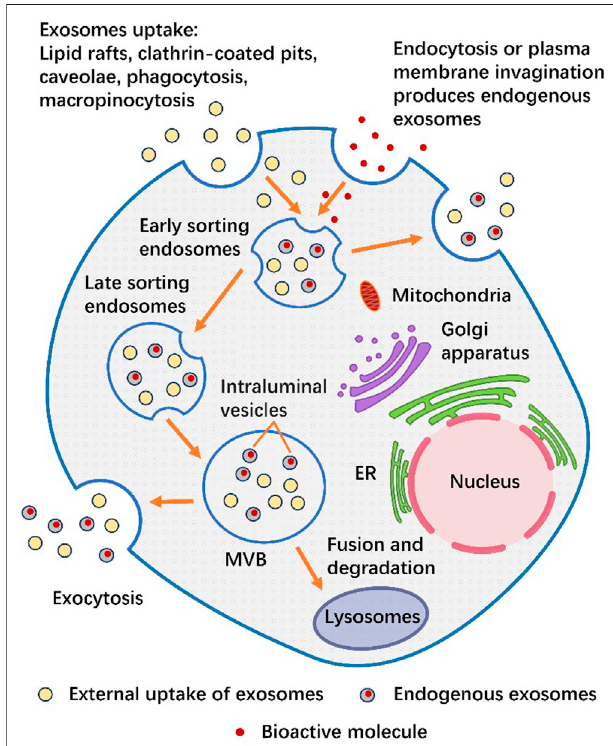
FIGURE 2 | The secretion process of exosomes. Exosomes can either produce endogenous exosomes through cytocytosis or plasma membrane invagination to take up bioactive molecules (nucleic acids, proteins, lipids, amino acids, or metabolites) (gray), or they can be secreted from the outside through lipid rafts, clathrin-coated pits, caveolae, phagocytosis or macropinocytosis in the form of external uptake of exosomes (yellow). The mixture of the two is aggregated in ESEs. During this period, the exosomes inside can either fuse with the plasma membrane and release exosomes outsidethecell,orfusedownwardtoformLSEsandthenformMVB.Onepart of MVB is released to the extracellular environment through exocytosis, while the other part is Fusion and degradation in the